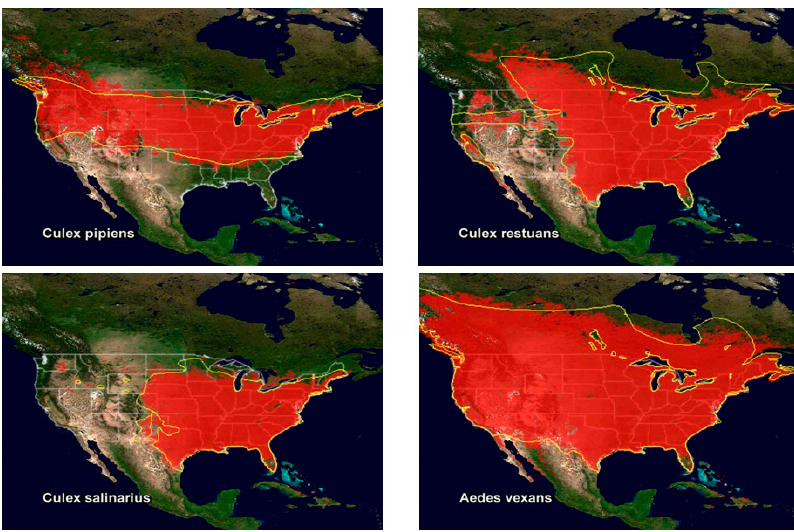
Figure 12. Maps showing the potential distribution of four species of mosquito in the United States. (Source: [83]).